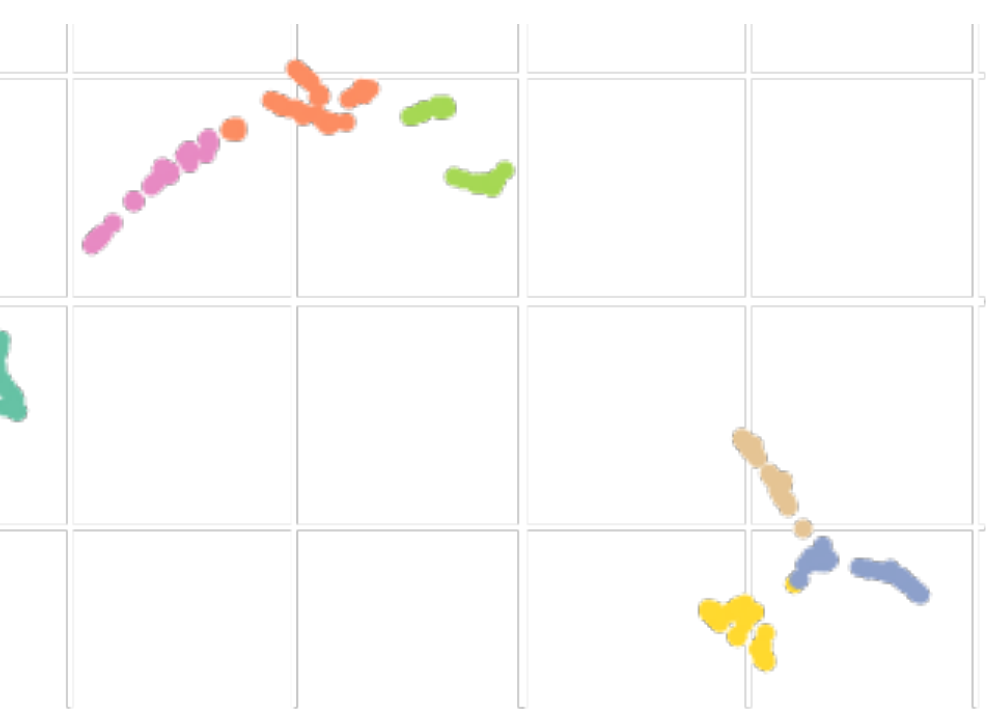
Figure 11. 2D UMAP embedding of the different countries and states studied. The colors represents different clusters generated using Affinity Propagation.